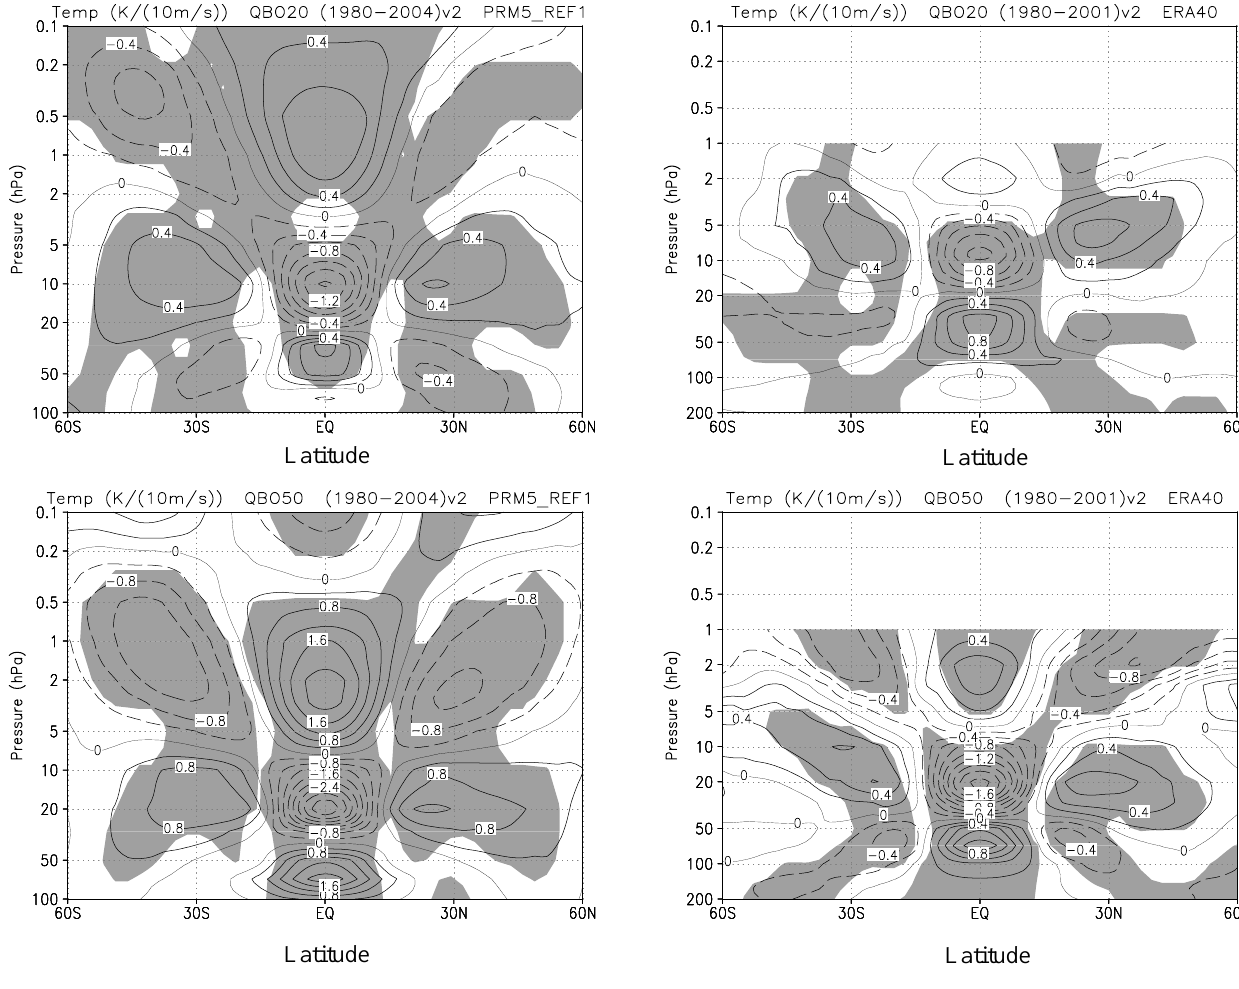
Latitude Latitude Fig. 13. Same as in Fig. 12 except for temperature in K/(10m/s). Contour interval is 0.2K/(10m/s) for QBO20 and QBO50, but 0.4K/(10m/s) for the QBO50 of the Fig.13 Same as in Fig.12 except for temperature in K/(10m/s). Contour interval is 0.2 K/(10m/s) for the QBO20 and QBO50, but 0.4 K/(10m/s) for the QBO50 of the model.